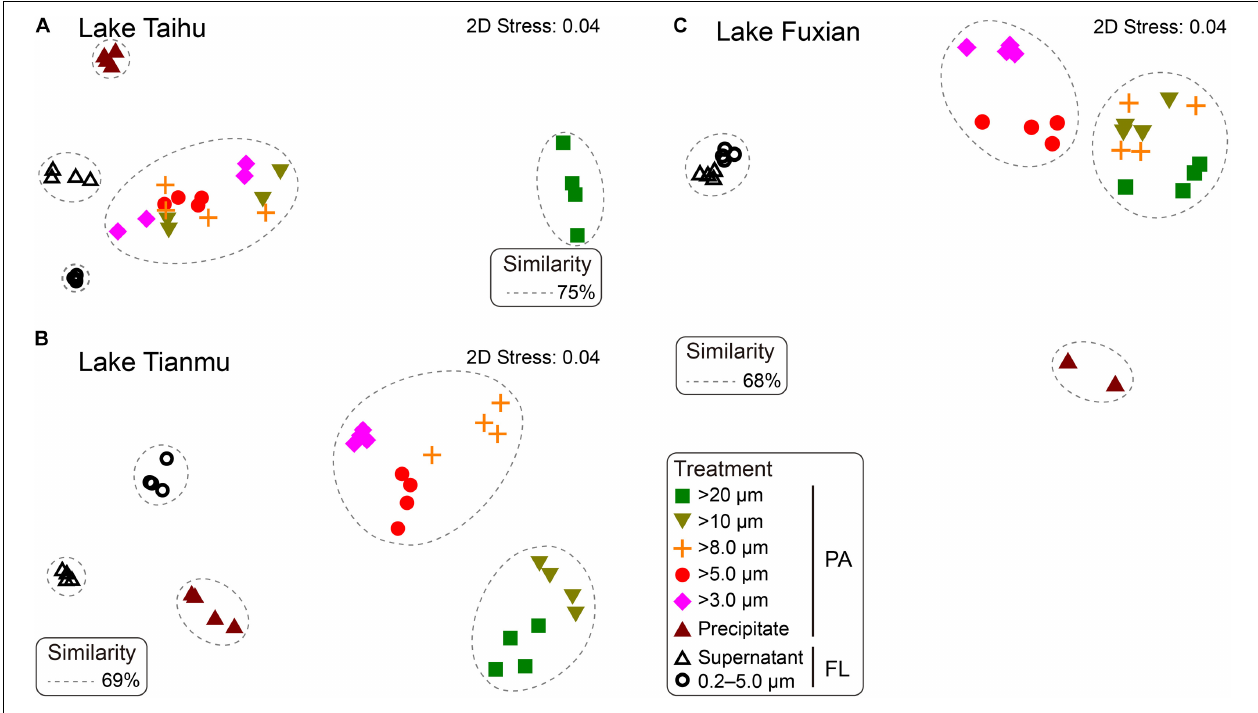
FIGURE 4 | Non-metric multidimensional scaling (nMDS) showing the distance between samples generated from different treatments in (A) Lake Taihu, (B) Lake Tianmu, and (C) Lake Fuxian. Samples with Bray-Curtis similarities of 75% in Lake Taihu, 69% in Lake Tianmu, and 68% in Lake Fuxian, respectively, are circled with dashed lines. PA, particle-attached; FL,